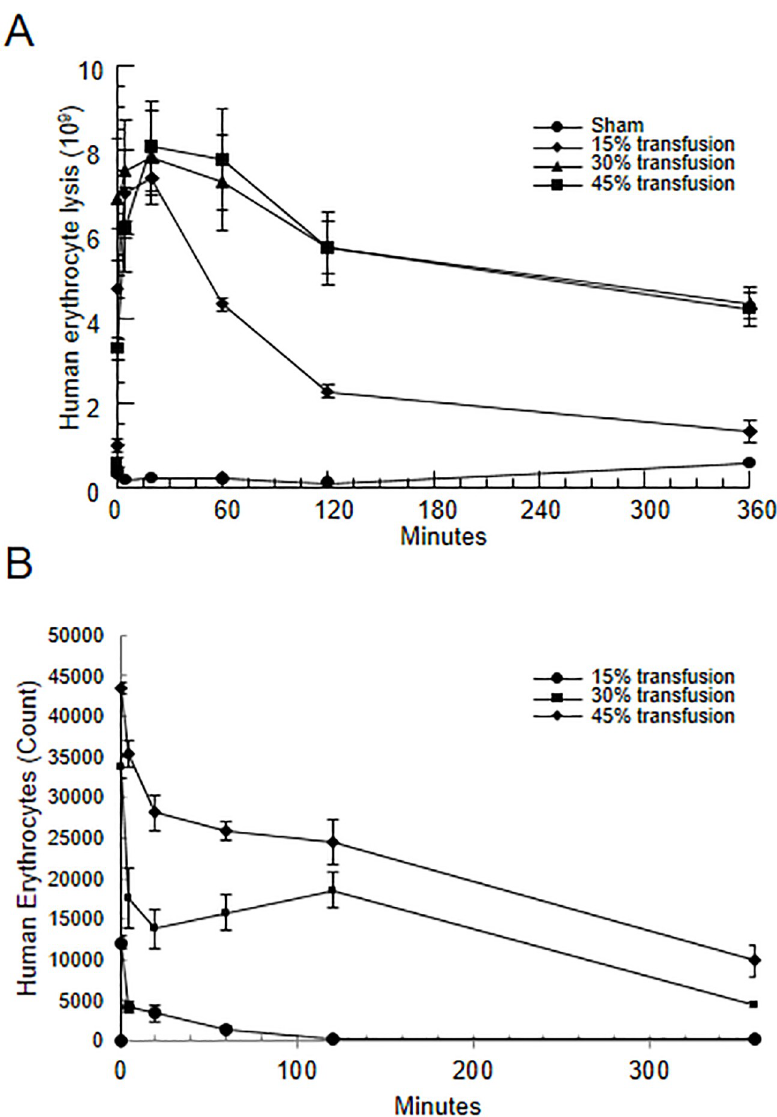
Fig 2. Optimization of human erythrocyte transfusion into rats. (A) Free hemoglobin present in rat plasma (expressed as an equivalent number of lysed erythrocytes) collected before transfusion (0) or 0.5, 5, 20, 60, 120 or 360 min after 15 (n = 3), 30 (n = 3) or 45% (n = 3) transfusion of human erythrocytes was measured by spectrophotometry. One group of sham animals (n = 3) was analyzed as well. (B) Absolute cell count of surviving human erythrocytes from 15 (n = 3), 30 (n = 3) or 45% (n = 3) transfusion of human erythrocytes were detected using FITC-conjugated anti- human CD235a (glycophorin A) monoclonal antibody at 0.5, 5, 20, 60, 120 and 360 min after transfusion as measured by flow cytometry. Clearance kinetics were standardized to injected erythrocytes at baseline (0 min). Data are means and standard error of the mean.